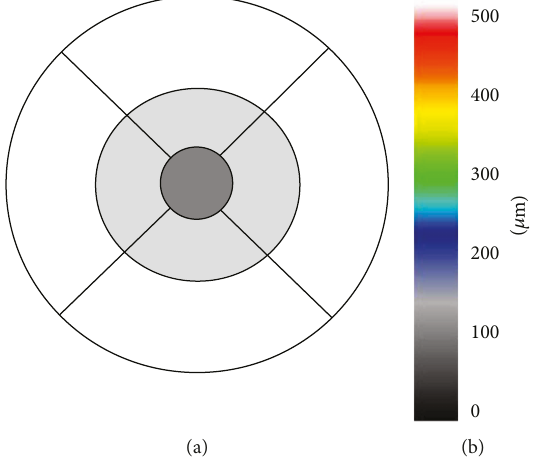
Figure 1: (a) Location of the three fi elds on the macular thickness map. Center: dark-gray fi eld; inner ring: light-gray fi eld; outer ring: white fi eld. (b) A sample of the false-color topographic image of optical coherence tomography